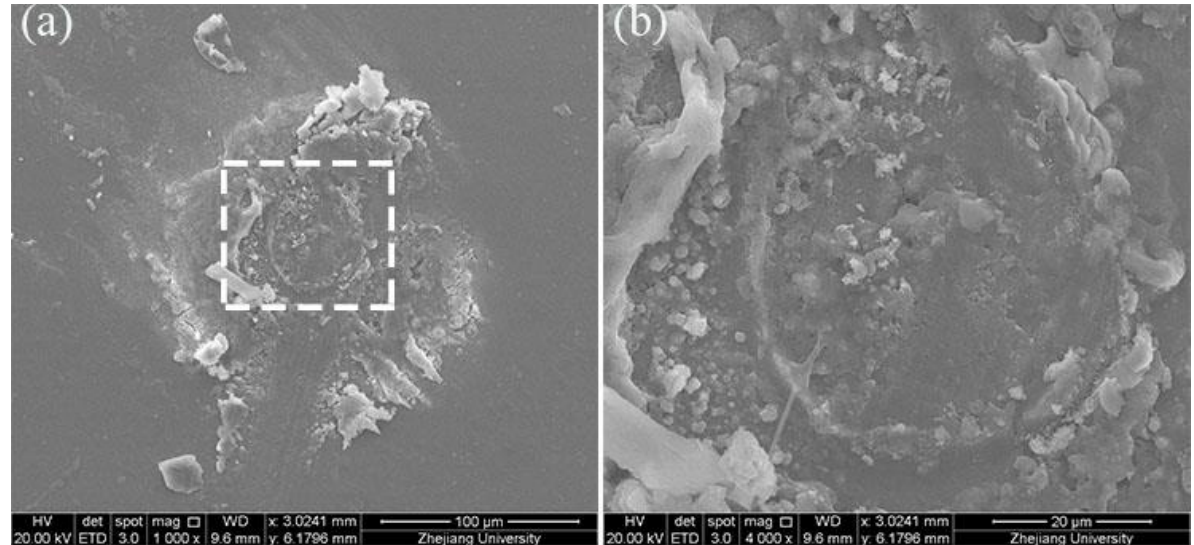
Figure 15. SEM photography of combustion residue of individual Mg microparticle, ( a ) the whole residue (1000×), ( b ) the local residue (4000×).